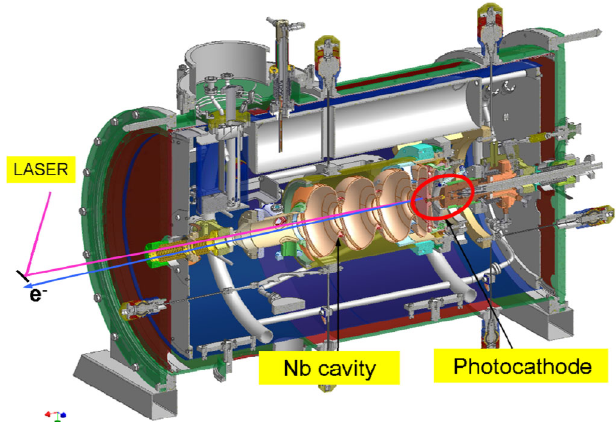
chamber.FIG. 1. (Color) Design of the SRF gun